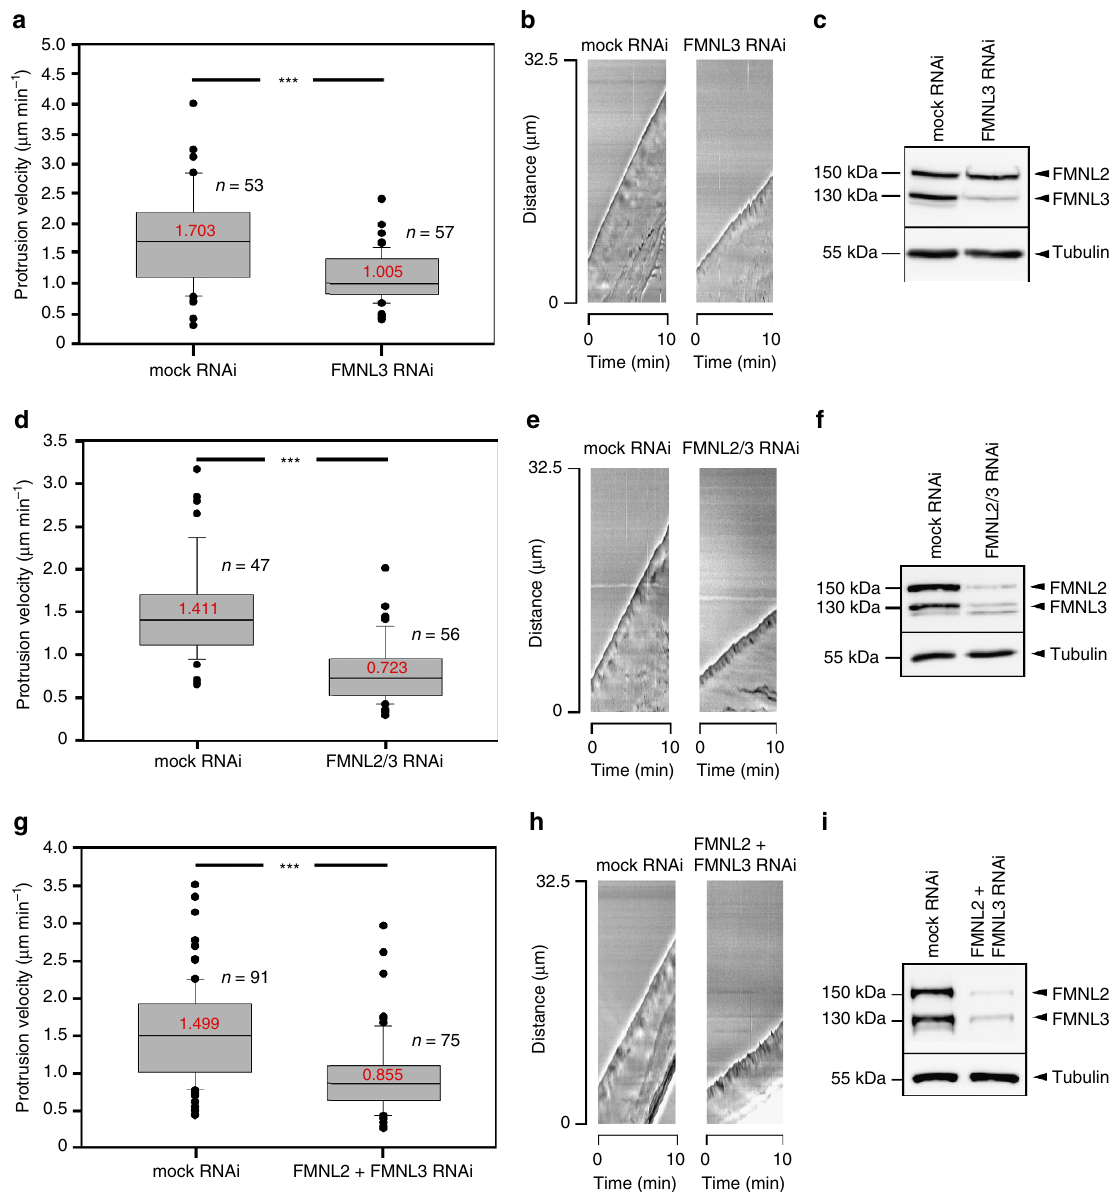
Figure 2 | Depletion of FMNL2 and -3 modifies efficiency of lamellipodium protrusion. Average protrusion velocities of B16-F1 cells upon knockdown of FMNL3 alone ( a – c ) or two alternative approaches of simultaneous knockdown of FMNL2 and FMNL3, either using one plasmid capable of knocking down expression of both proteins (FMNL2/3 RNAi; d – f ) or two plasmids targeting both messages specifically (FMNL2 þ FMNL3 RNAi; g – i ). ( a , d , g ) Box and whiskers plots with median values given in red, boxes including 50% (25–75%) and whiskers 80% (10–90%) of all measurements; outliers are shown as dots. n , number of cells analysed. Measurements were aided by assembling kymographs ( b , e , h ) of phase contrast movies. Knockdown efficacies were documented for each individual experiment, with representative western blots shown in c , f , i . Tubulin was used as loading control. *** p o 0.001 by Mann–Whitney rank sum